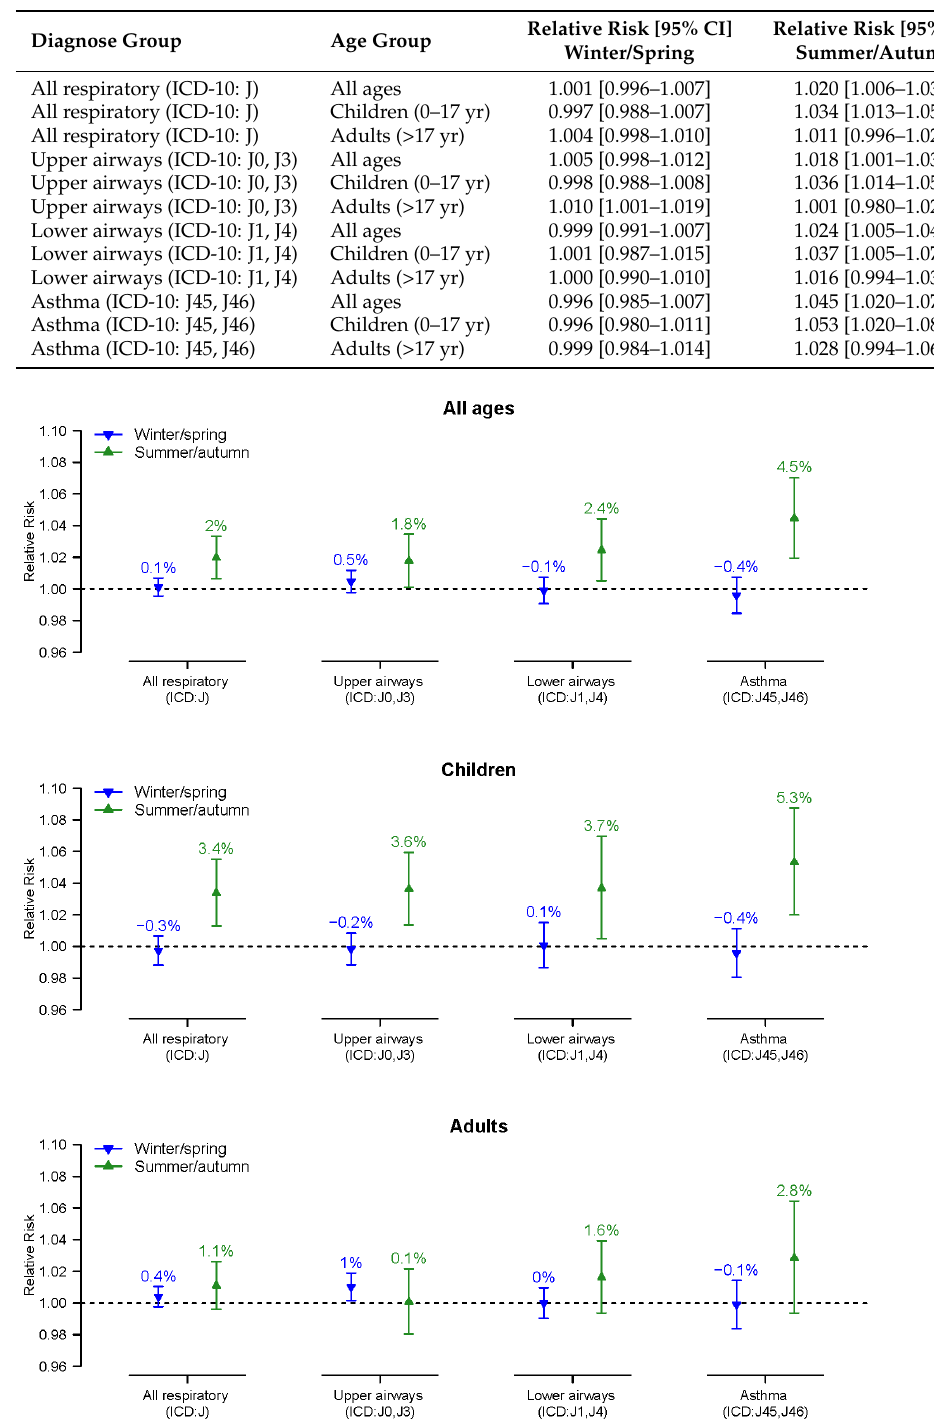
Figure 2. The relative increase (RR with 95% CI) in respiratory visits at all healthcare units in Visby associated with a 10 µg m − 3 increase in PM 10 during the period of 2013–2019. All ages at the top, children (0-17 years) in the middle, and adults (>17 years) at the bottom. These analyses are divided into all respiratory diseases (ICD-10: J), upper airways (ICD-10: J0, J3), lower airways (ICD-10: J1, J4), and asthma (ICD-10: J45, J46) during winter/spring (January-April) and summer/autumn (May–